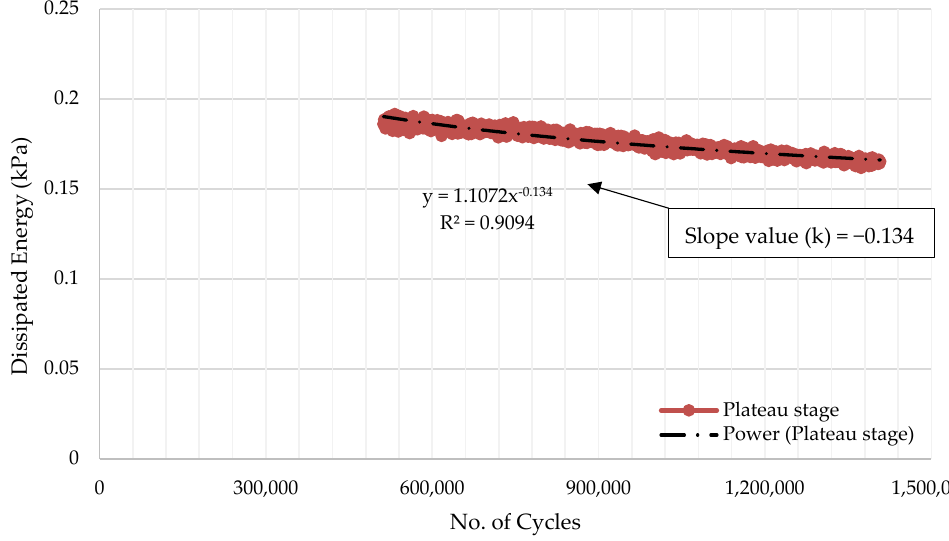
Figure 7. Example of calculation of the exponential slope value (k) of the fitted DE-Loading Cycle for PV computation using Carpenter and Shen’s approach [87].